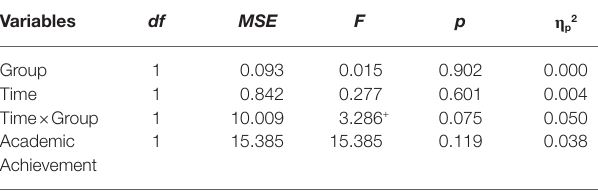
TABLE 2 | The statistical results of